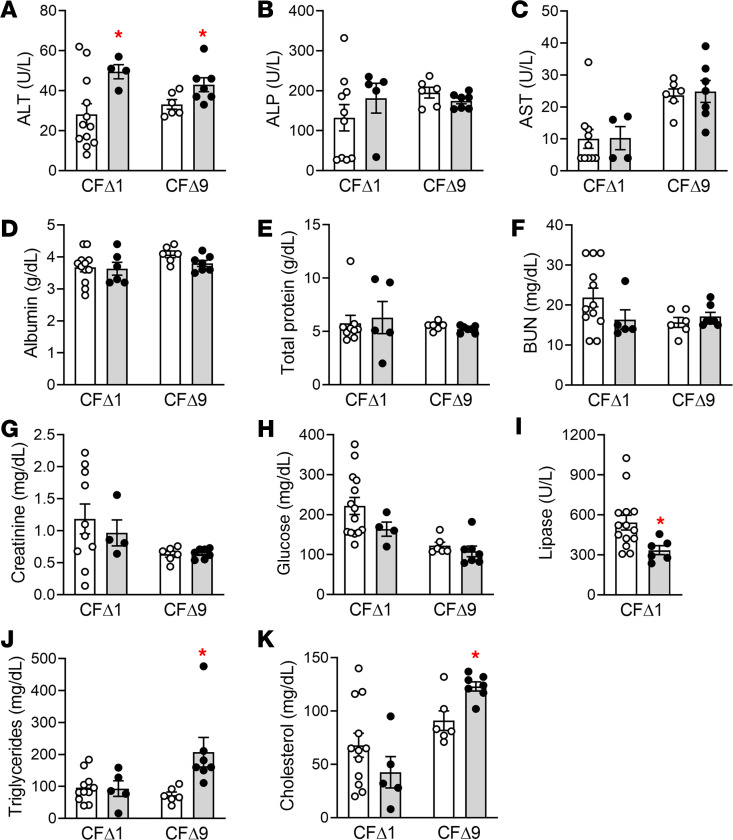
Blood metabolic panel in WT and CF rabbits.(A–K) Blood chemistry panel for liver, pancreatic, and renal parameters in 2- to 3-month-old WT and CF rabbits from the Δ1 line raised at UNC (n = 6–14 WT/Het, white column, white dots; n = 4–6 CF, gray column, black dots) or from the Δ9 line raised at UM (n = 6 WT white column, white dots; n = 7 CF, gray column, black dots). All rabbits were in stable clinical conditions at collection. ALT, Alanine aminotransferase; ALP, alkaline phosphatase; AST, aspartate aminotransferase; BUN, blood urea nitrogen. *P < 0.05 CF versus WT, unpaired, 2-tailed t test.